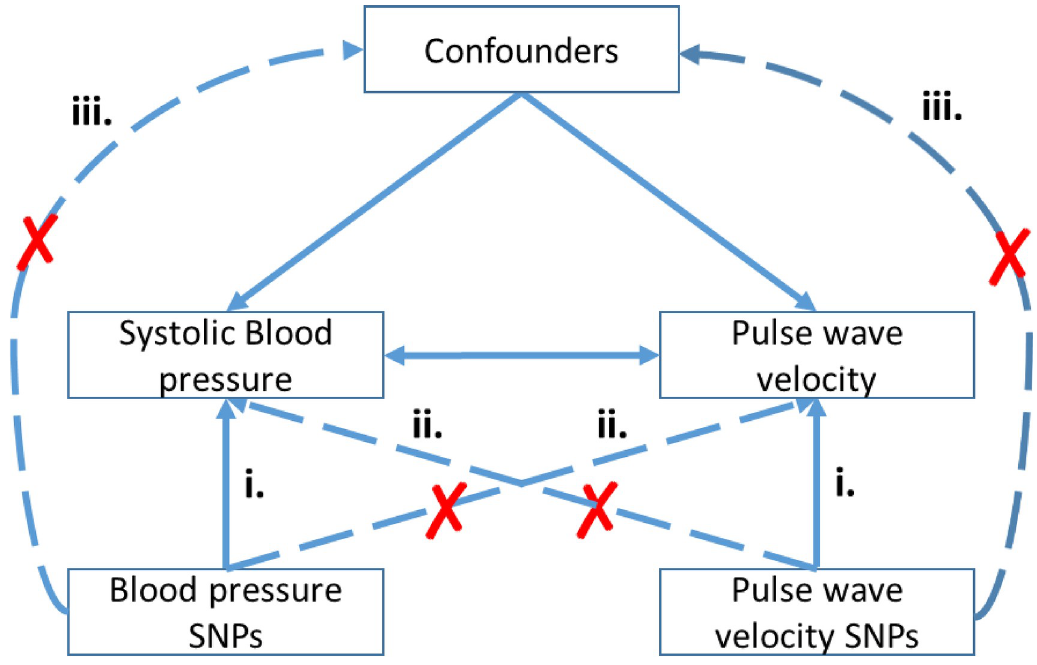
Fig 1. Bidirectional Mendelian Randomization: To use Mendelian randomization three conditions have to be fulfilled: (i.) There is an association between the SNP and the risk factor, (ii.) the SNP has no association with the outcome and (iii.) the SNP is independent of factors that confound the SNP-outcome relationship. To analyse the causal relationship of BP on PWV, we use as instruments BP SNPs reported by Evangelou [39], which were also nominal significant in our cohort.